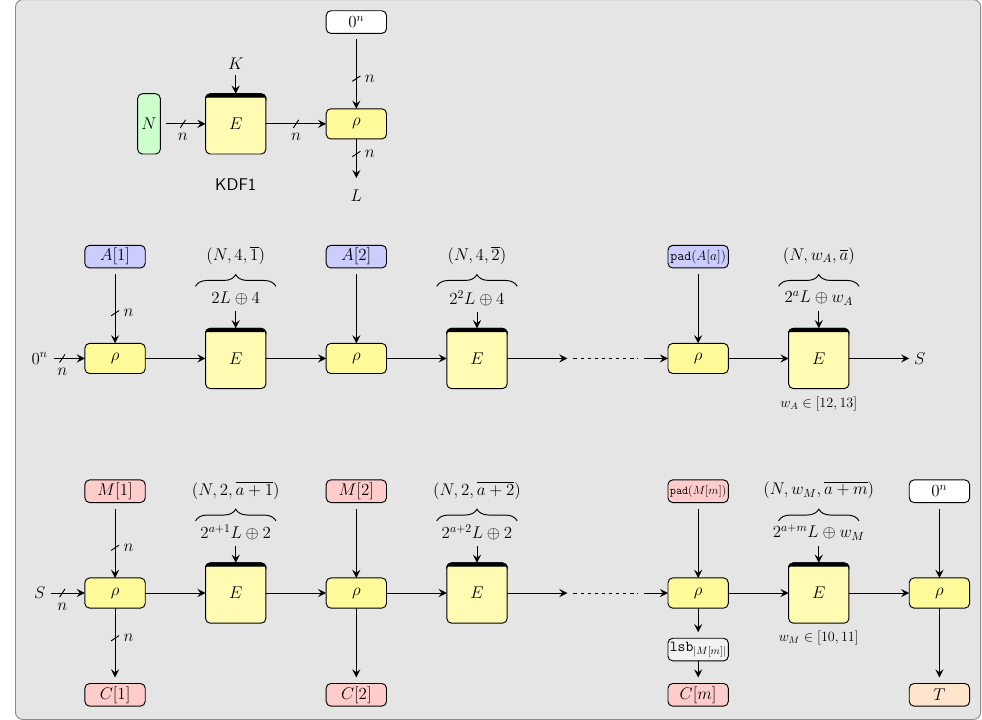
Figure 7: Remus-N with ICE1 ( Remus - N 1). (Top) Key derivation. (Middle) Processing of AD. (Bottom) Encryption. The domain separation B being of 8 bits only, ‘ B is to be interpreted as ‘ 0 120 } B